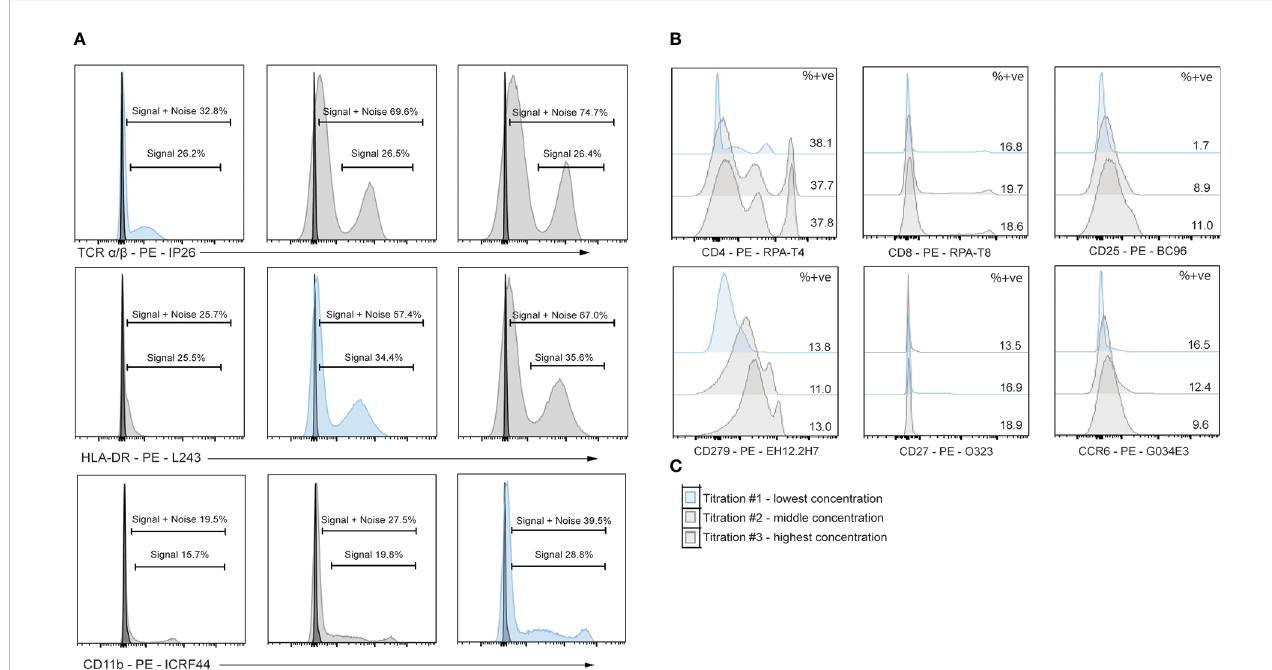
FIGURE 5 Titrations of fl ow cytometry antibodies corresponding to oligo-antibody clones in the TotalSeq-C catalogue reveals optimal staining conditions. PBMCs were stained using PE antibodies against the marker of interest and performed in 3-fold serial dilutions. Dilution chosen is shown in blue. (A) Example titrations showing percent positive noise + signal and percent positive signals. The titration chosen is the dilution that does not lose positive signal yet has the least signal + noise percent positive. (B) 3-point titrations performed on markers affected by enzymatic digestion. (C) Example legend for histograms shown in B, where the top plot is titration #1 and the lowest dilution, middle plot is titration #2 and the middle concentration, and the bottom plot is titration #3 and highest concentration of antibody.